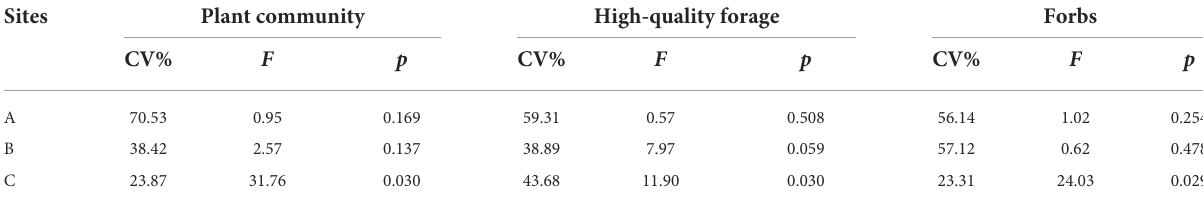
TABLE 1 Effects of free-grazing on nutrient storages of plant community, high-quality forage, and forbs based on the Adonis2 analysis for the three alpine grassland sites (A–C). Sites Plant community High-quality forage